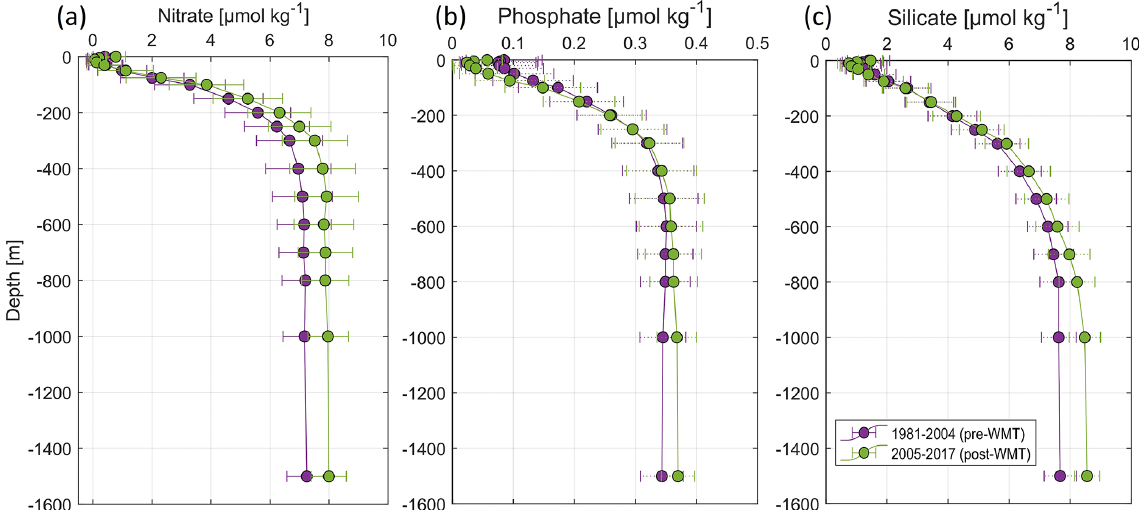
Figure 22. Climatological mean vertical profile and standard deviation of (a) nitrate, (b) phosphate and (c) silicate over the WMED